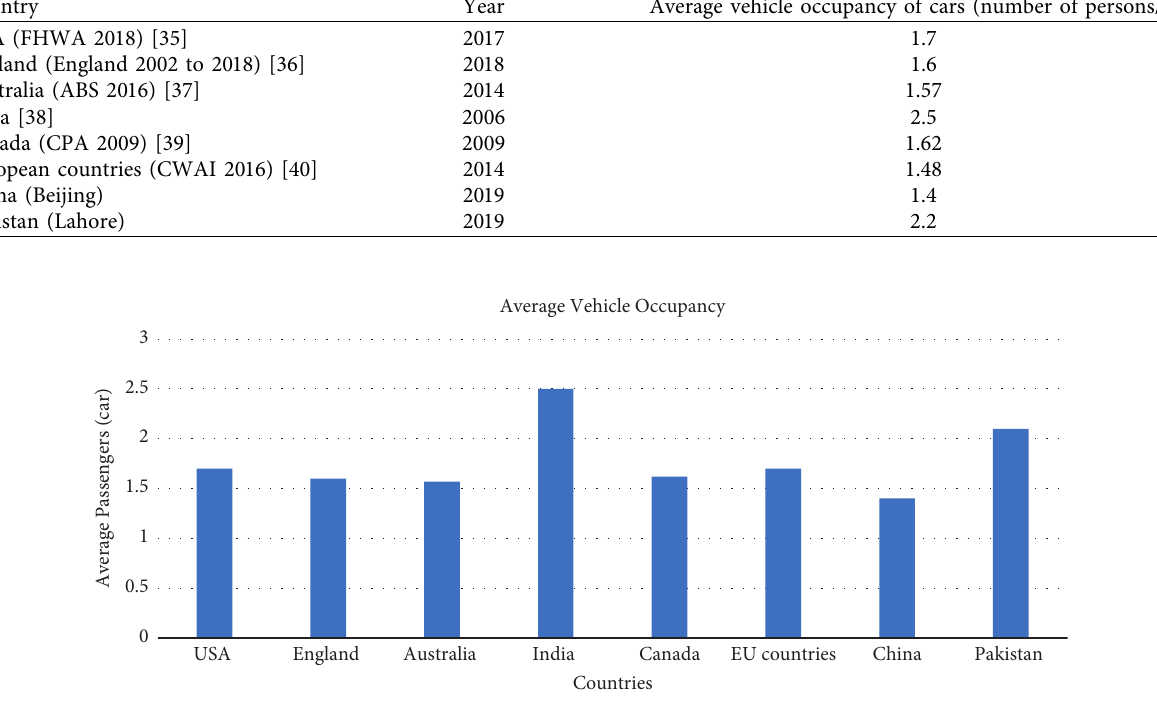
Figure 43: Average vehicle occupancy of cars in different